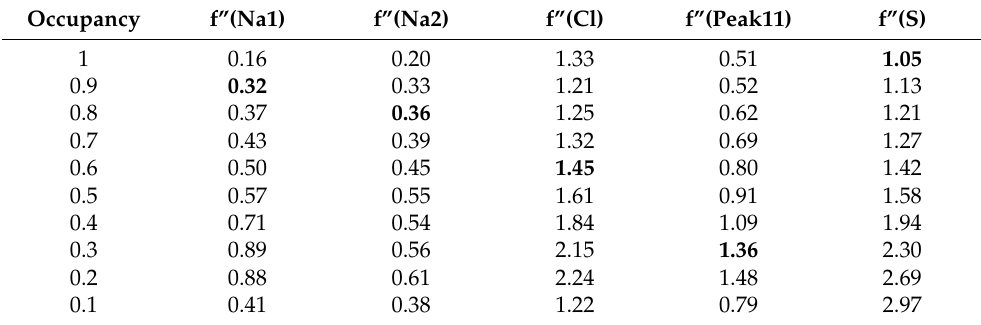
Table 2. Scattering-factor refinements for anomalously scattering elements. f”(S) shows the average value of all sulfur scatterers. Refined f” values are in